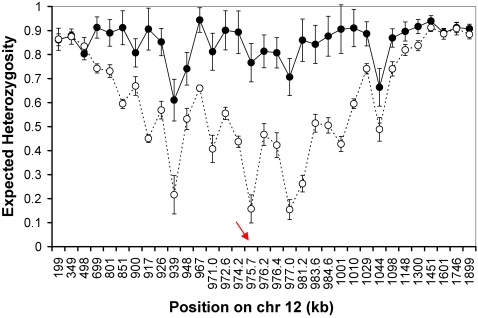
Genetic Diversity on chr. 12 in Thailand and Laos.Expected Heterozygosity plotted across chr. 12 in Thailand and Laos. The red arrow marks the position of gch1. Markers are ordered on the x-axis which is not shown to scale.